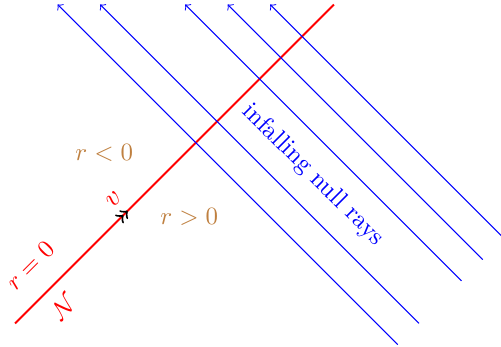
Figure 1 . Section of null hypersurface N at r = 0 in rv -plane. Infalling null rays traverse N at different values of advanced time v . Each point on the red line corresponds to a transverse surface N v